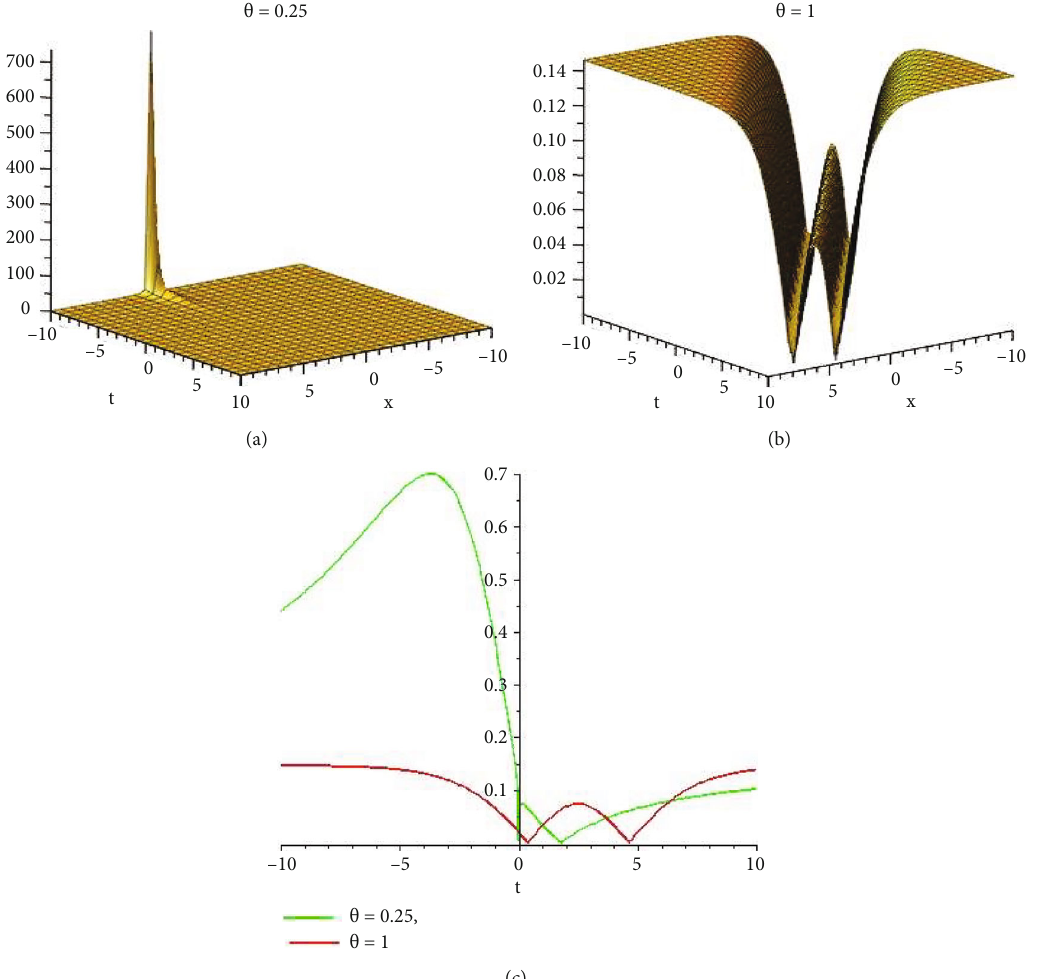
, t Þ . (a, b) 3D plot and (c) 2D combined plot for x = 1 8,9 ð x